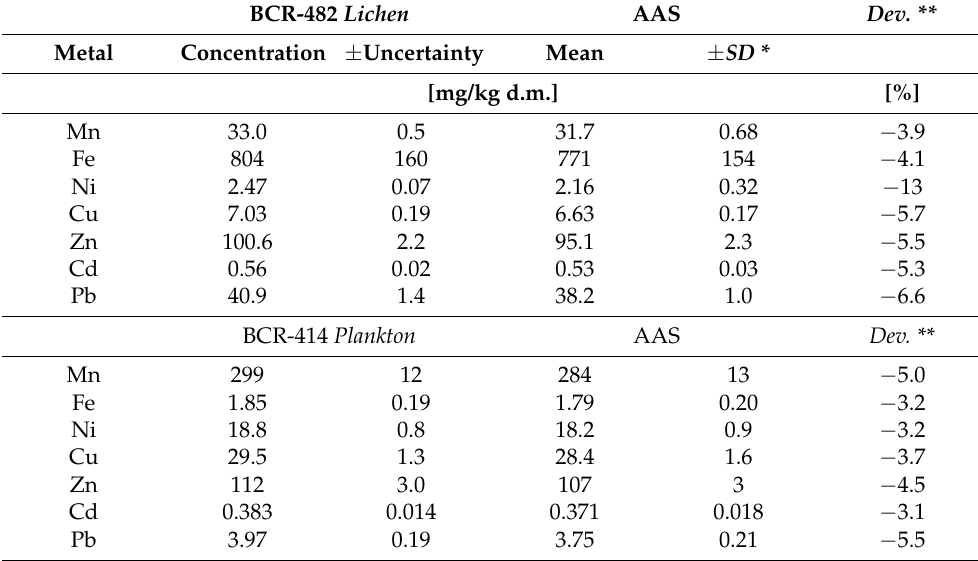
Note: * standard deviation. ** relative difference between the measured (c m ) and certified (c c ) concentration 100% * (c